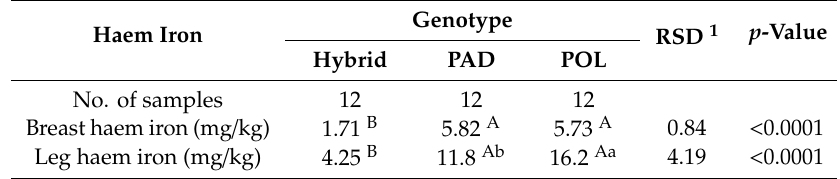
Table 3. E ff ect of genotype (Hybrid, PAD, POL) on haem iron content of breast and leg meat. Haem Iron